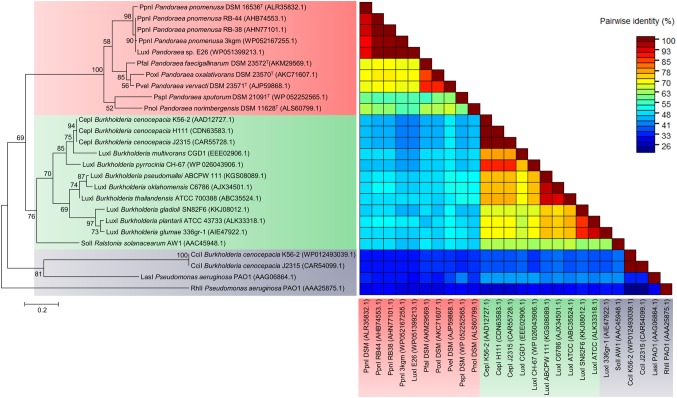
LuxI phylogenetic tree and pairwise identity matrix analyses of Pandoraea species and closely related species. LuxI of Pandoraea species form a distinct cluster against LuxI of Burkholderia species and P. aeruginosa representing an evolutionary distinct branch of QS system. Bootstrap values (expressed as percentages of 1,000 replications) greater than 50%. Bar, 0.2 substitutions per amino acid position.